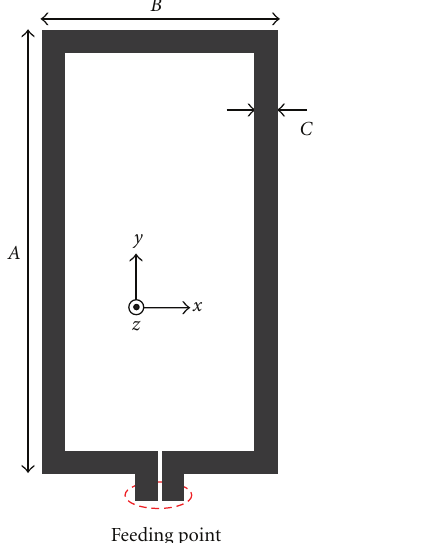
Figure 8: Geometry of the reference rectangular loop antenna. Table 1: Dimensions of the reference rectangular loop antenna. Dimension A B C Size (mm) for 2.45 GHz 48.8 26 2.5 Size (mm) for 3.35 GHz 37 19.1 2.5 Size (mm) for 5.5 GHz 22 11.8 1.5